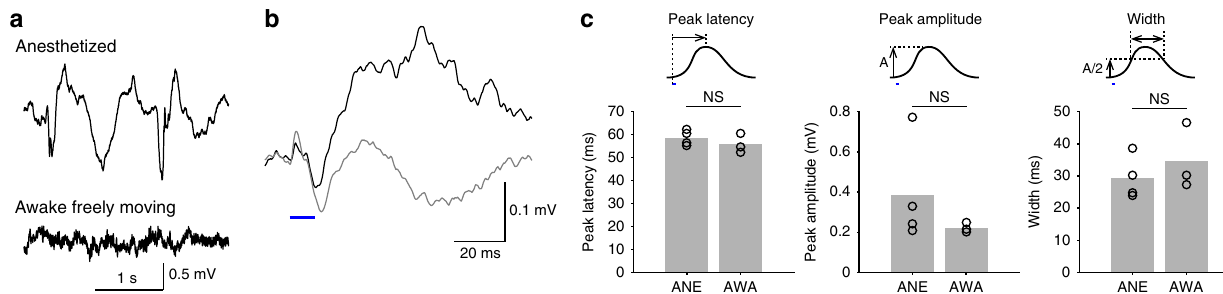
Fig. 4 Optogenetically evoked surface potentials in the awake brain. a In agreement to numerous previous studies, the surface potential recorded in the awake brain shows high-frequency components compared with the anesthetized brain. b Average trace of 50 measurements of surface potential with ( black ) and without the late spike ( gray ). Blue bar indicates the timing of L5 light stimulation. c Summary of characteristics in the anesthetized and awake brain (all p > 0.05, Wilcoxon rank sum test, 4 anesthetized animals vs 3 awake